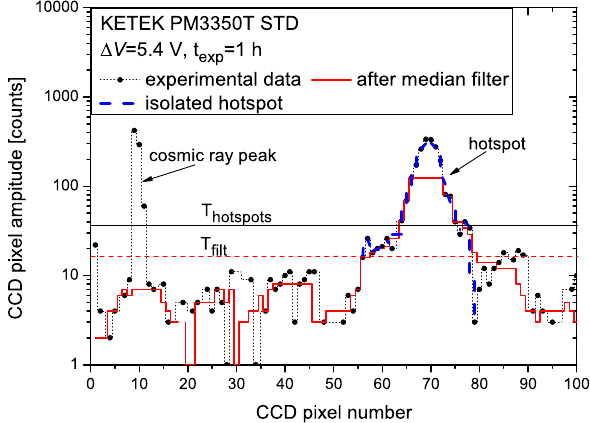
Fig. 7 Example of a hotspot and a cosmic ray peak